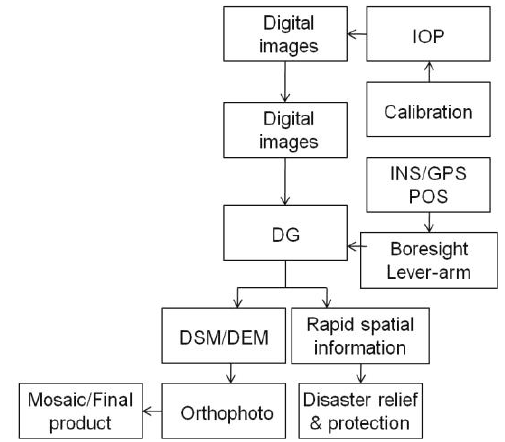
Figure 10. Proposed DG-ready photogrammetric